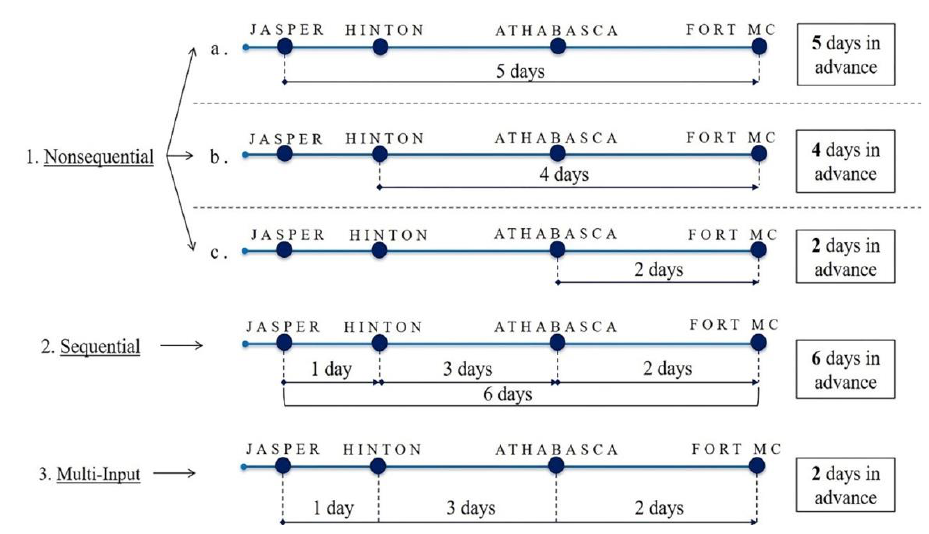
Figure 5. Schematic representation of the models and their lead times.